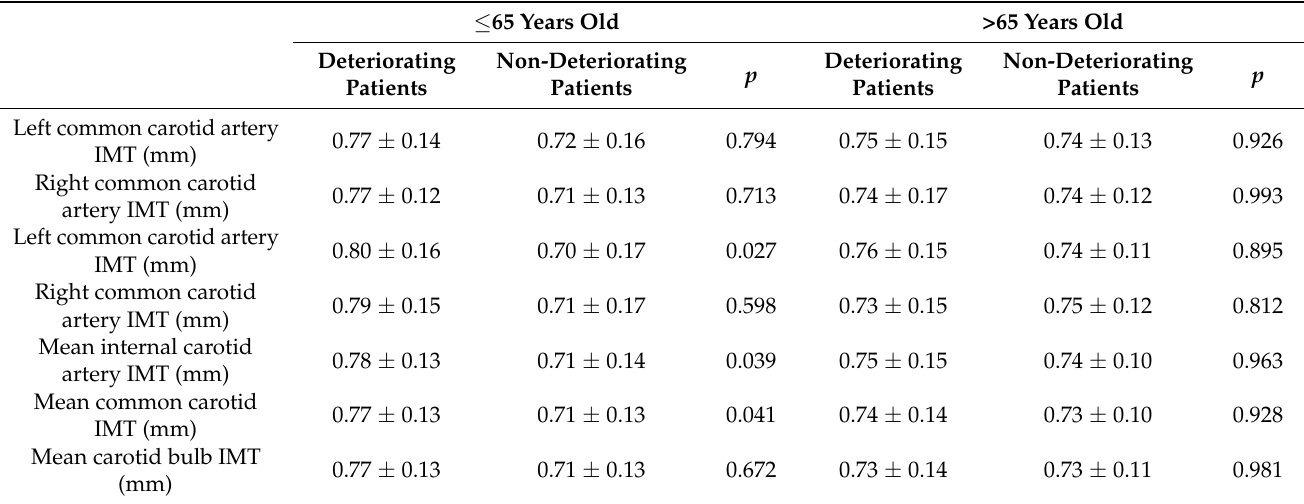
Table 4. Subclinical atherosclerosis by median age and phenotype.